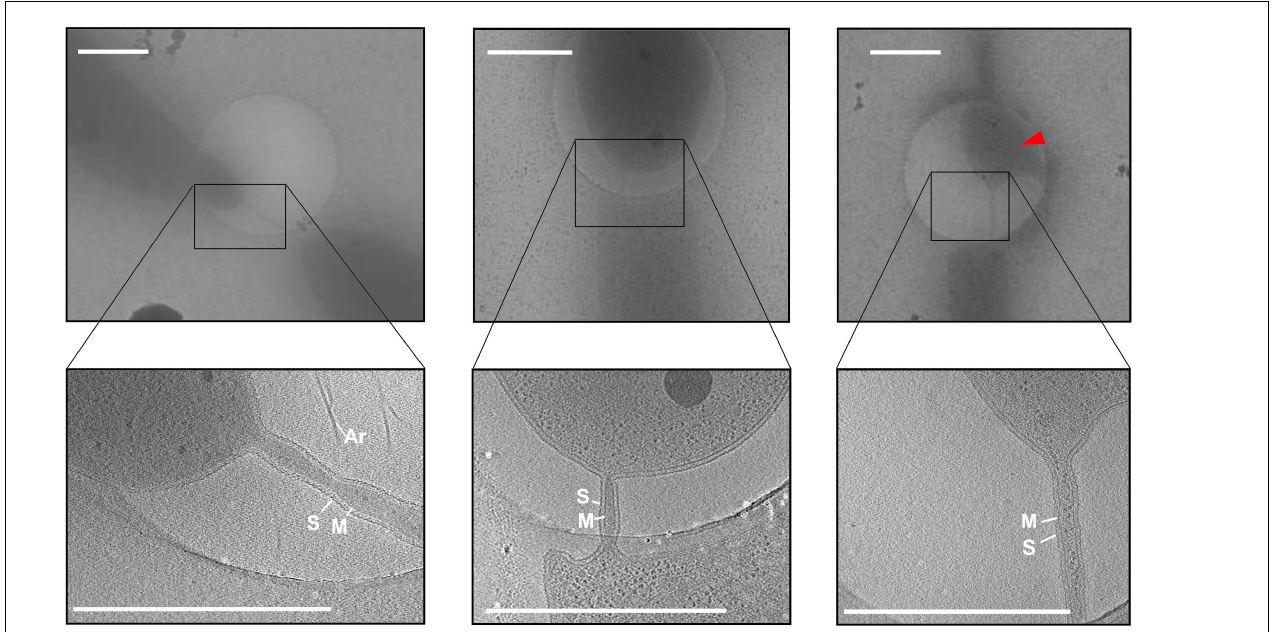
FIGURE 2 | Electron cryo microscopy and tomographic slices of cell–cell bridges in H. volcanii . Low magnification cryo micrographs of cell–cell bridges targeted for cryoET (upper panels) with the corresponding tomographic slice from a reconstructed tilt series (lower panels). The electron cryo micrographs as well and the corresponding slice through tomograms depict the variety in shape, length and width of the cell–cell bridges. The right panel shows a partially ruptured cell indicated by a red arrow. Scale bars are 1 µ m. The cytoplasmic membrane (M), the S-layer (S), and archaella (Ar) are indicated.